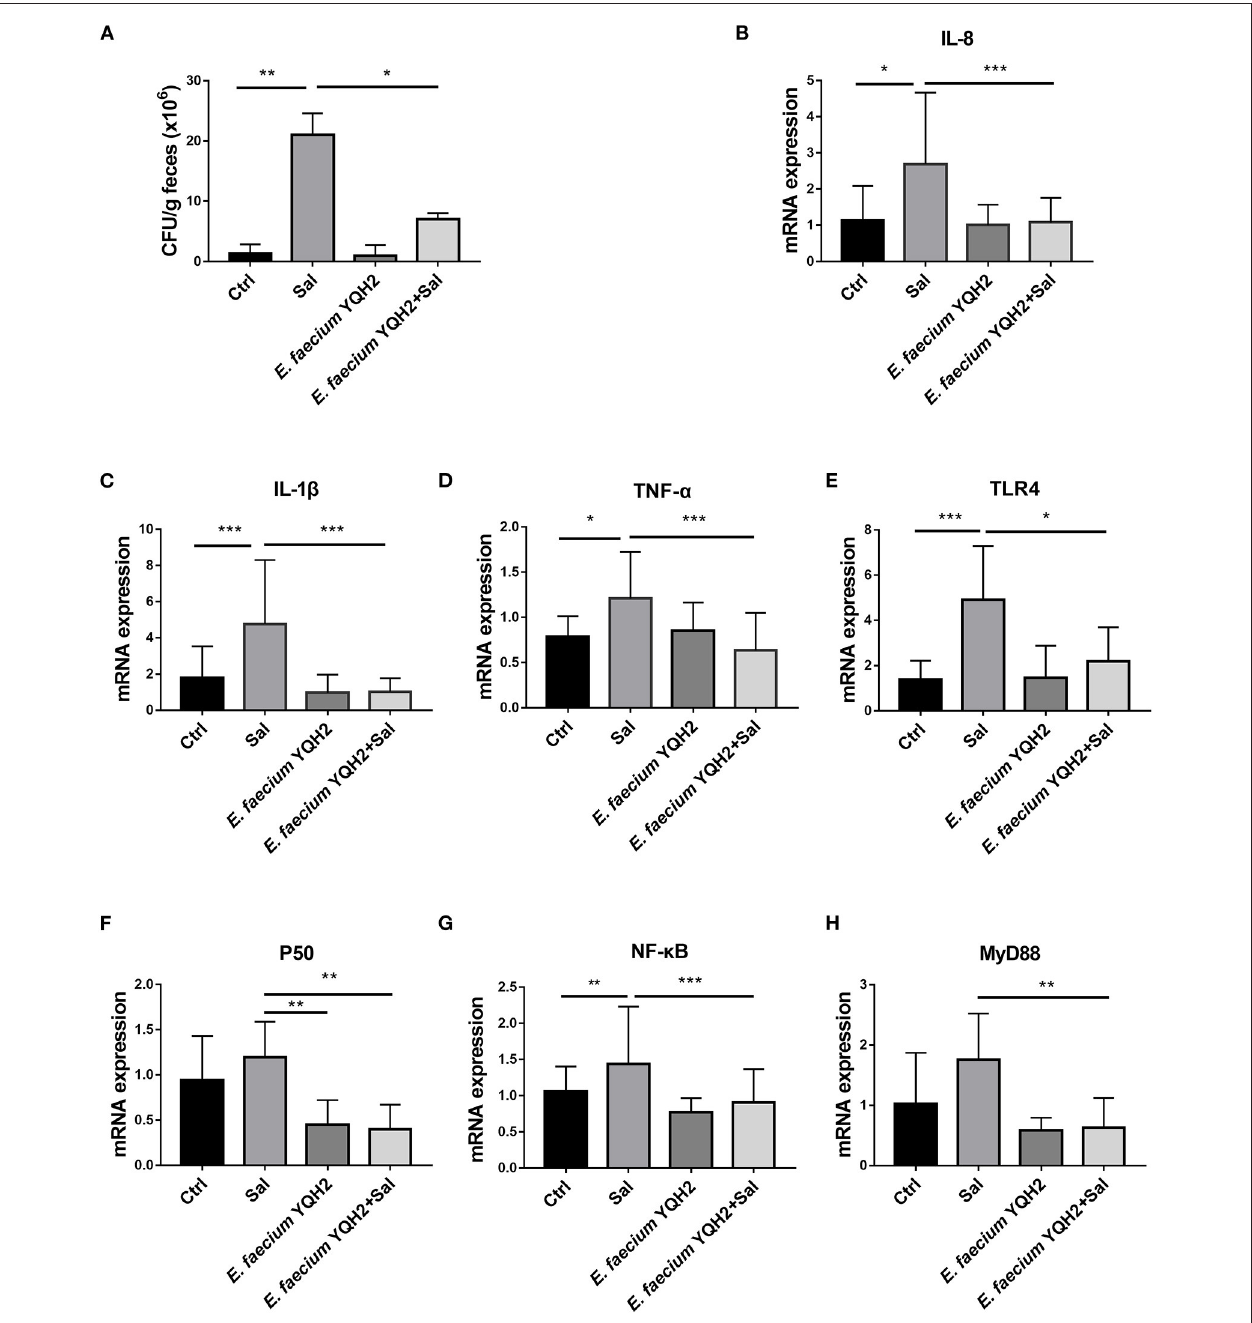
FIGURE 2 | Enterococcus faecium YQH2 downregulated the NF- κ B signaling pathway to improve the inflammation. (A) The level of S. typhimurium in feces was detected by colonization test. (B–H) The mRNA expressions of IL-8, IL-1 β , TNF- α , TLR4, P50, NF- κ B, and MyD88 detected by RT-qPCR, n = 8. * p < 0.05, ** p < 0.01, *** p <